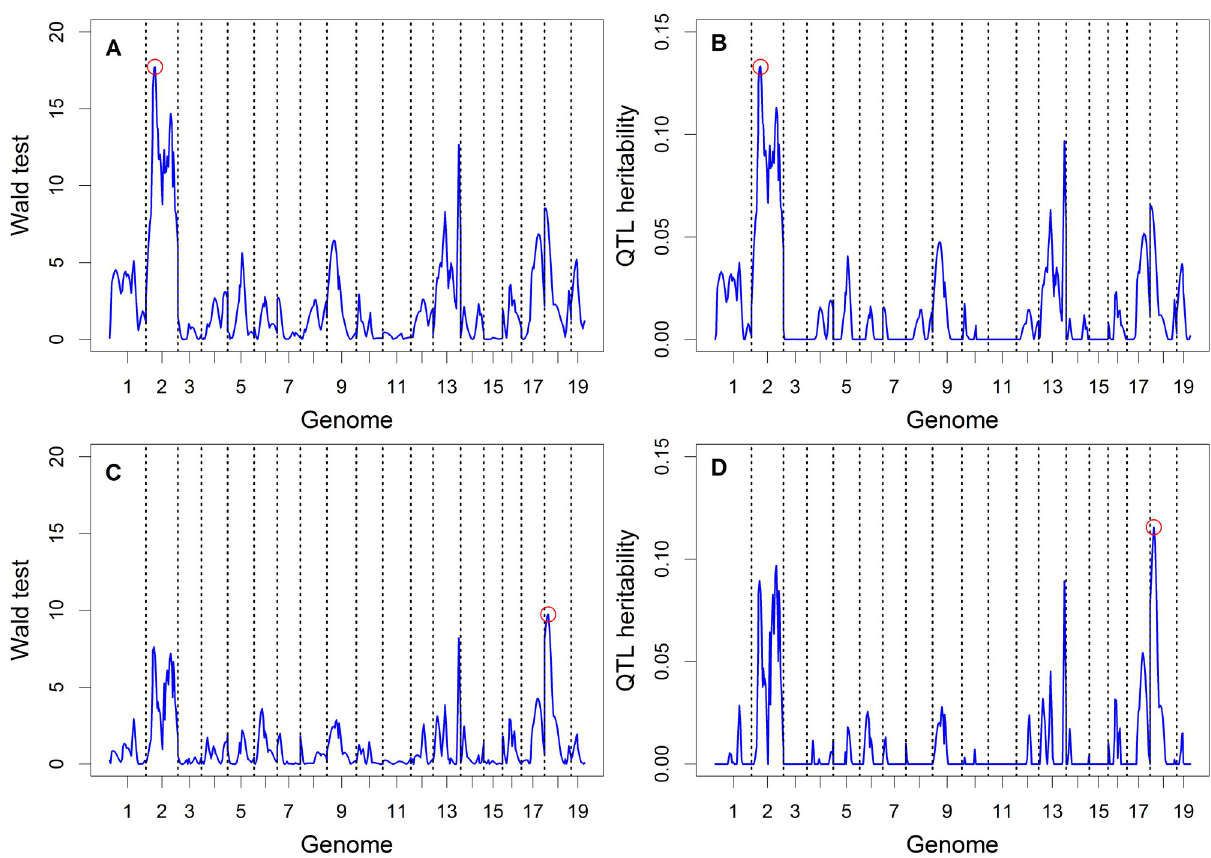
Fig 7. Wald tests and estimated QTL heritability for body weight of the F 2 mouse population. (A) and (C) show the Wald test statistics from interval mapping and polygenic mapping, respectively. (B) and (D) show the estimated QTL heritability from interval mapping and polygenic mapping,